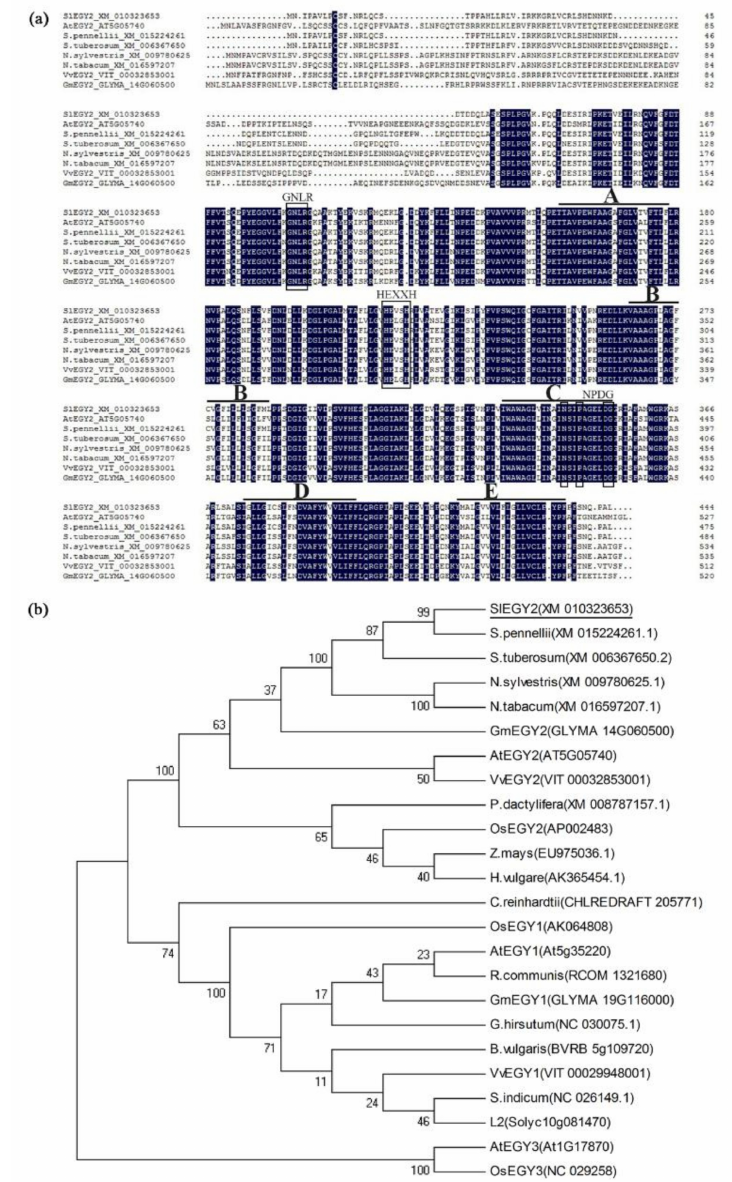
Figure 1. The homologous amino acids sequence alignment and phylogenetic tree analysis of SlEGY2. ( a ) Multiple sequences alignment of SlEGY2 with other homologous proteins in other species. Three conserved motifs (HEXXH, GNLR, and NPDG) in metalloproteases are remarked in black framers. Six predicted transmembrane topologies (A–E) are marked in black lines. Transmembrane topology is predicted by ExPASy (http://web.expasy.org/protscale/, accessed on 6 October 2018). ( b ) Phylogeny analysis of SlEGY2. Phylogeny was generated by using the Neighbor Joining (NJ) method of MEGA. Bootstrap analyses were obtained with 1000 replicates and the percentage values over 50 were brought out. The accession numbers of proteins are shown in